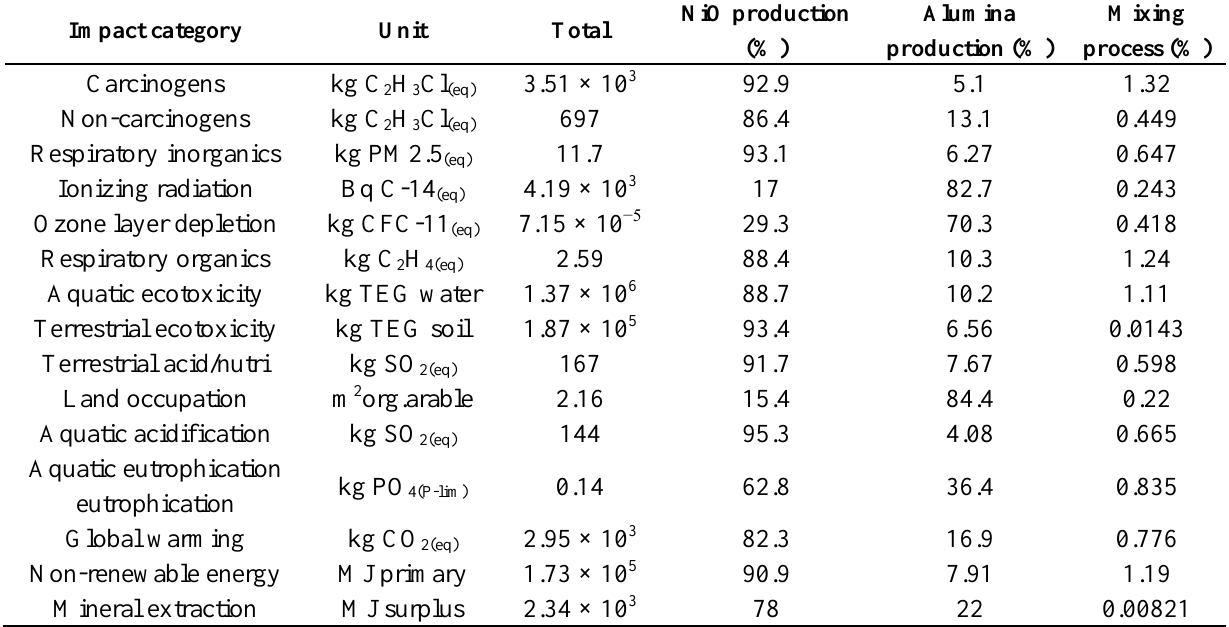
Table 3. Characterization life cycle impact assessment (LCIA) results of metal catalyst production. Functional unit = 396 kg/day. CFC: chlorofluorocarbon; and TEG: triethylene